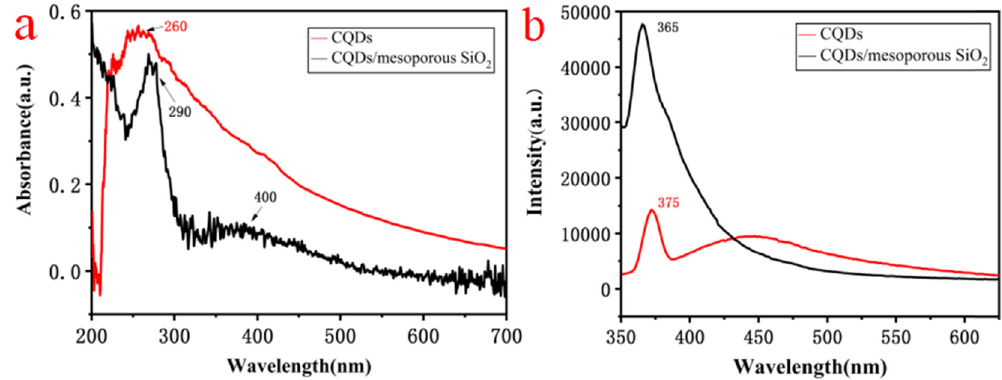
Figure 3: ( a ) UV - Vis spectra of CQDs and CQDs/mesoporous SiO 2 , and ( b ) fl uorescence emission spectra of CQDs and CQDs/meso - porous SiO 2 .